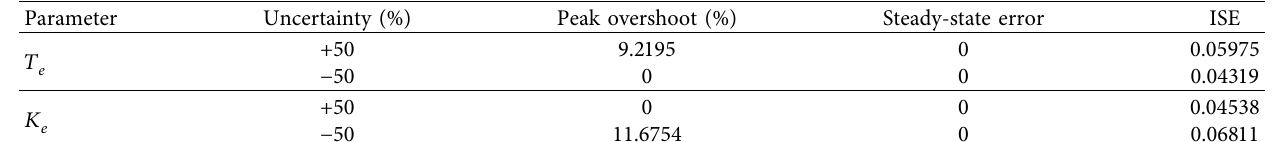
Figure 13: Response of terminal voltage using MESOBC for normal and ± 50% uncertainties in K Table 7: Robust response specifcation of MESOBC-based AVR under ± 50% uncertainties in exciter. Parameter